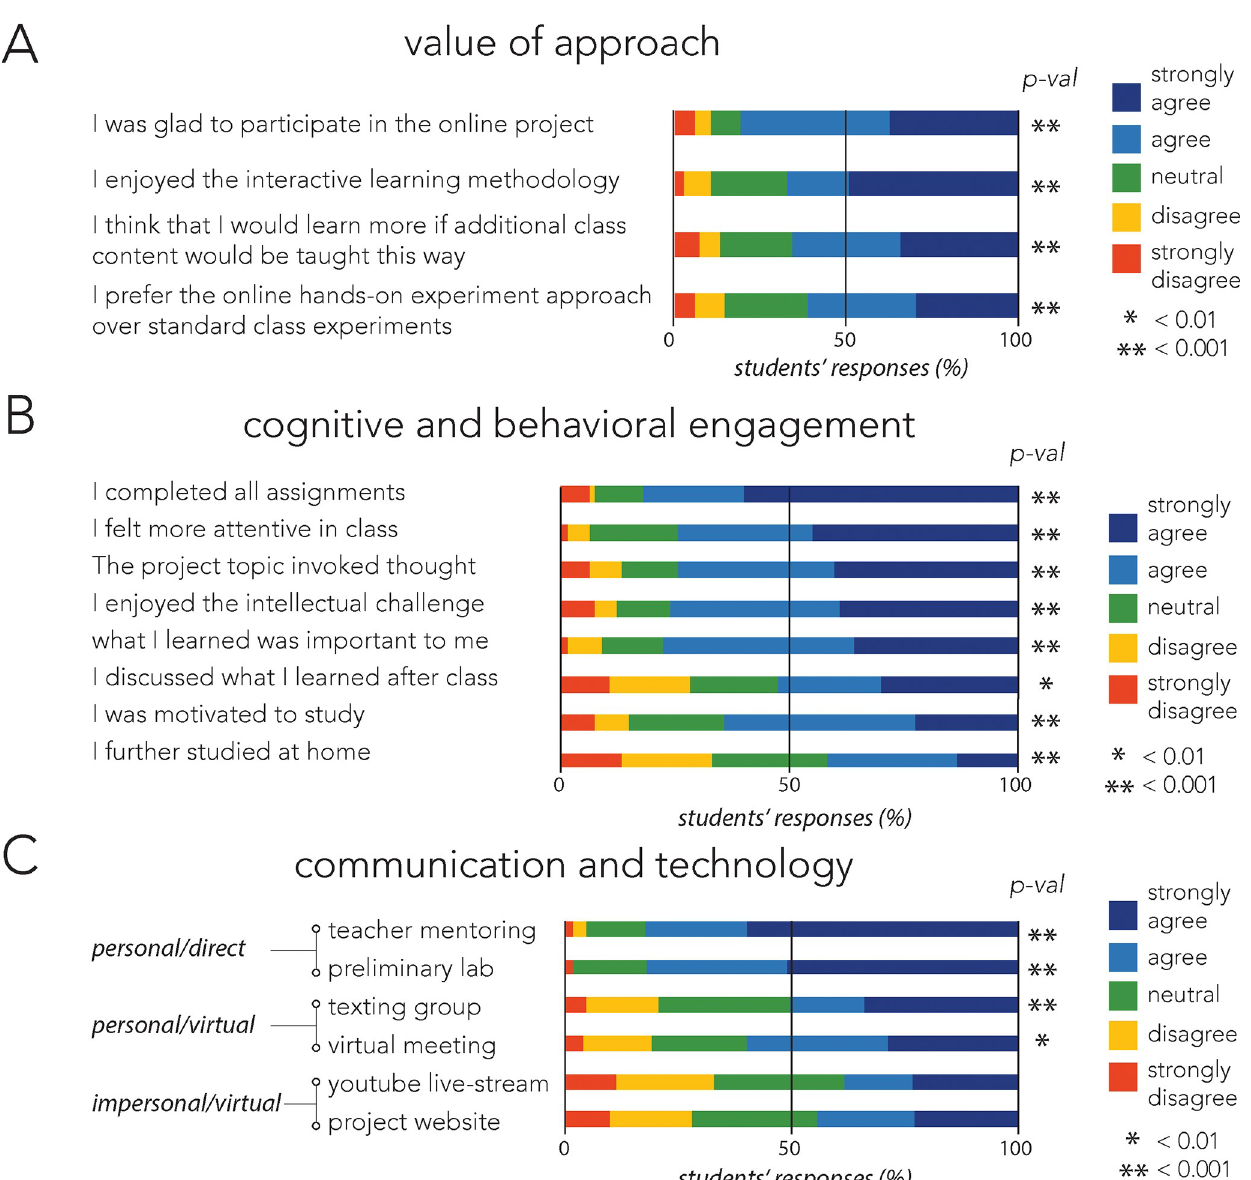
Fig 3. Results from student questionnaires and statistical significance for deviation from neutral (Wilcoxon test). (A) Students’ self-reporting on the value of interactive approach ( N = 67). (B) Students’ self-reporting on cognitive and behavioral engagement ( N = 67). (C) Students’ self-reporting on the value of different teaching and communication technologies ( N = 42–69). The questionnaires were filled out by Israeli students, and results reflect the relative fraction of each response category collected from all responding students. Results from teacher questionnaires are provided as S2 Fig.